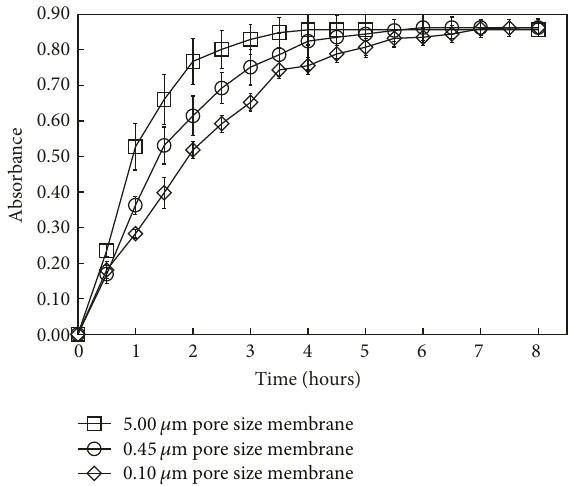
Figure 6: Absorbance curves of Coomassie Brilliant Blue G-250 measured in the solution at different diffusion times. Initially, 1% Coomassie Brilliant Blue G-250 was used as the diffusion solution in the donor cell.